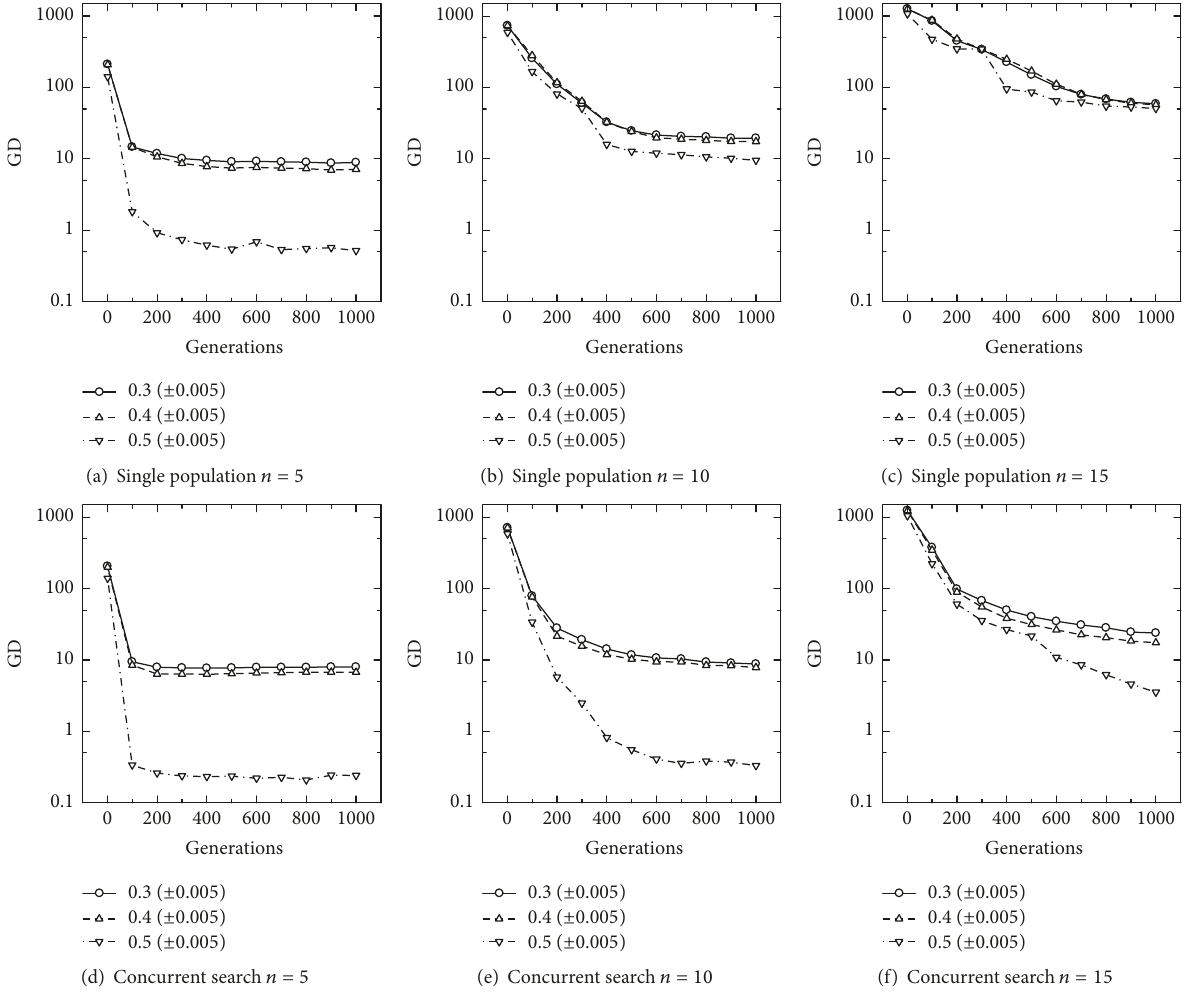
Figure 9: GD over the generations by single population method and proposed concurrent search method. DTLZ3, 𝑚 = 3 original objectives, 𝑀 = 5 objectives in the extended space, and 𝑛 = {5, 10, 15} variables. GD is calculated separately grouping solutions around the preferred values 𝑥 5 = 0.3 and 𝑥 5 = 0.4 and optimal value 𝑥 5 = 0.5 . Solutions are considered within a group if 𝑥 5 = 0.3 ± 0.005 , 𝑥 5 = 0.4 ± 0.005 , or 𝑥 = 0.5 ± 0.005 , 5